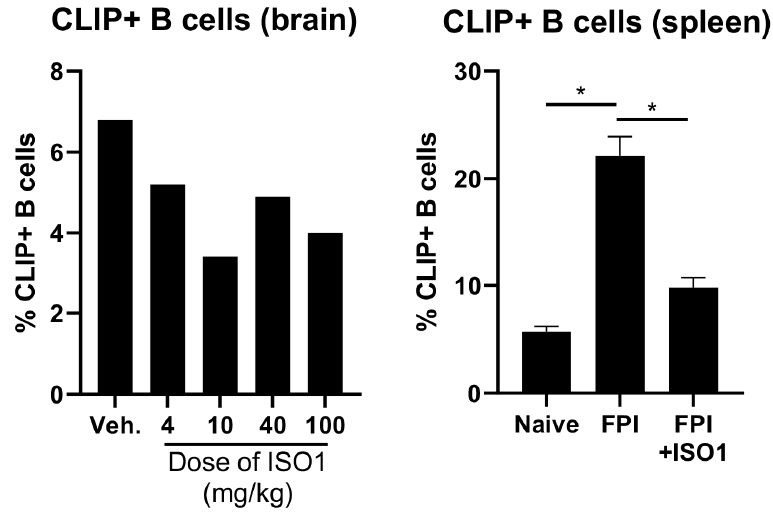
Figure 3. Dose–response curve of ISO1 given at 30 min after FPI, examining immune cell penetration into the brain at 24 h after FPI. We administered ISO1 at 30 min after FPI and performed flow cytometry on leukocytes isolated from the brain to ascertain the optimum dose of ISO1 and to assess what percentage of isolated are CLIP+ B cells. It should be noted that very few cells were isolated from naïve mice, so that was removed from the graph. Cells were stained with anti-CD19 and counter-stained with Anti-MHC class II invariant chain CLIP. The results indicate that a 10 mg/Kg dose of ISO1 administered 30 min after FPI provided the most robust decrease in % of B cells that express CLIP (* p < 0.05).